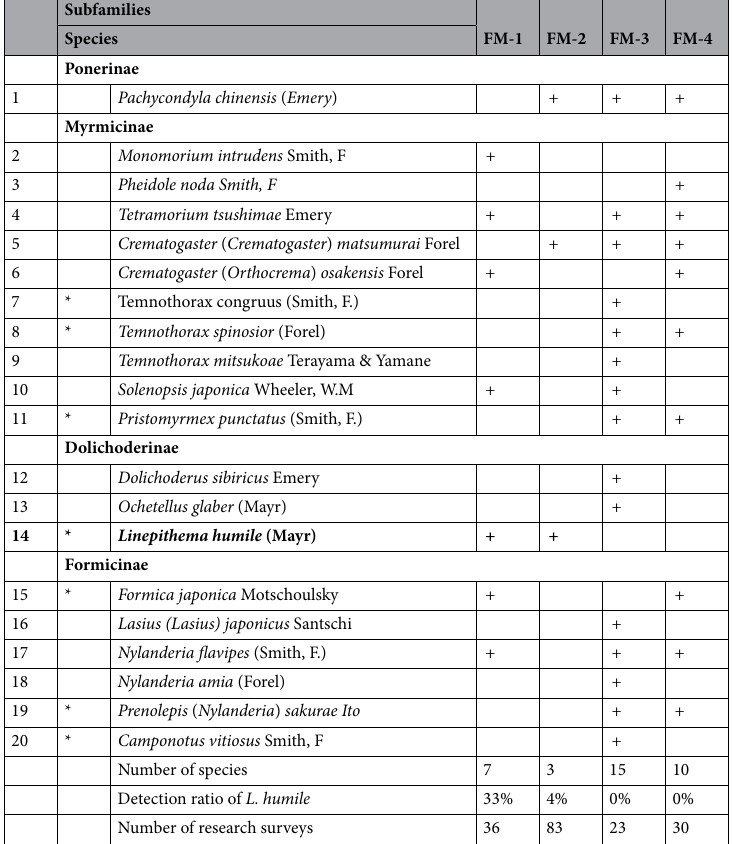
Table 2. Ant species list observed with traditional surveys at Fushimi area in 2018. Species shown in bold letters represent the target species ( Linepithema humile ). “+” is marked in the box for species that were detected at least once. *Overlapping species that were also found on Port Island, Kobe. “Number of species” includes L. humile.